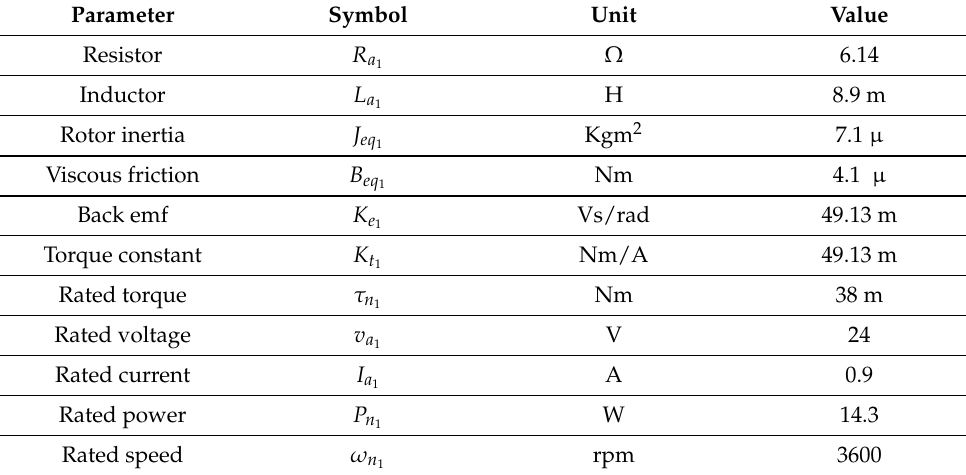
Table 2. Data GR 42 × 25 DCM1 .